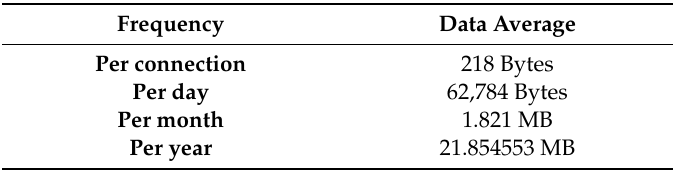
Table 4. Transmission load for each container 1 .